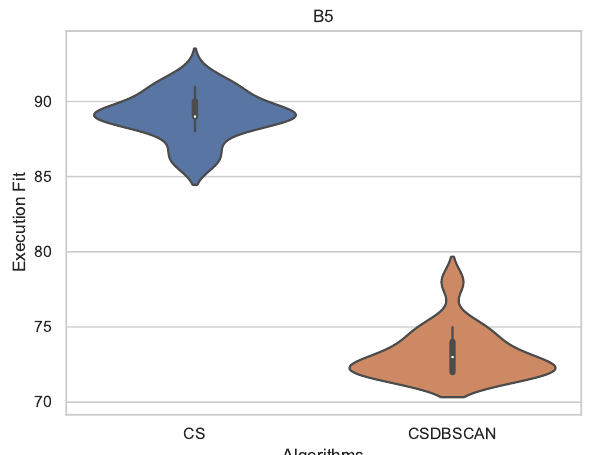
Figure 7. Instance A.5 distribution.